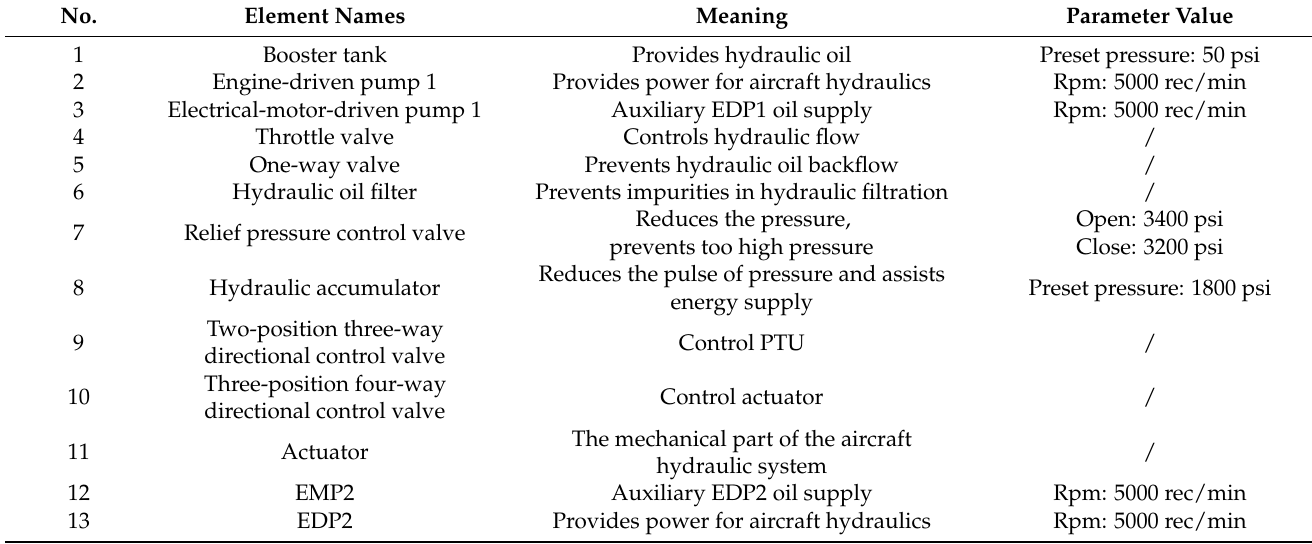
Table 1. Parameters of the simulation